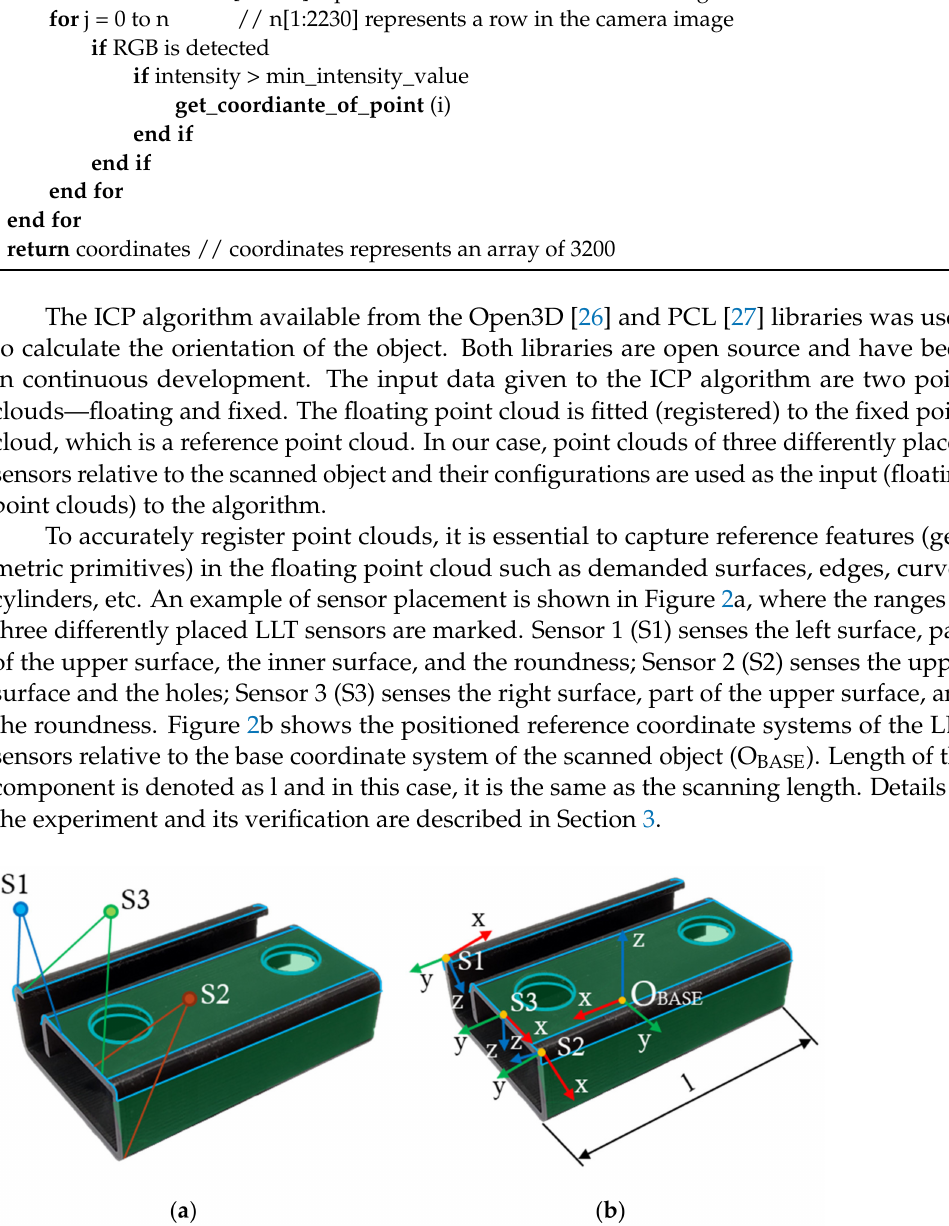
Figure 2. Methodology of LLT sensor placement (S1 is sensor no. 1, S2 is sensor no. 2, S3 is sensor no. 3): ( a ) the measurement ranges of sensors S1, S2, and S3; ( b ) coordinate systems S1, S2, and S3 represent the reference coordinate systems of LLT sensors, O BASE is the object coordinate system; l is the scanning